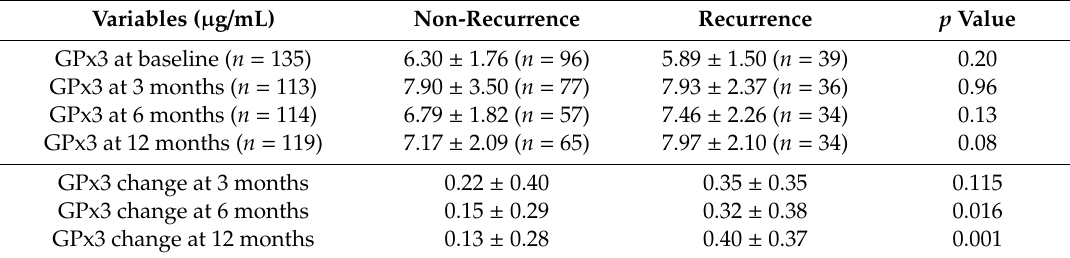
Table 3. Mean GPx3 and GPx3 change between the recurrence and non-recurrence